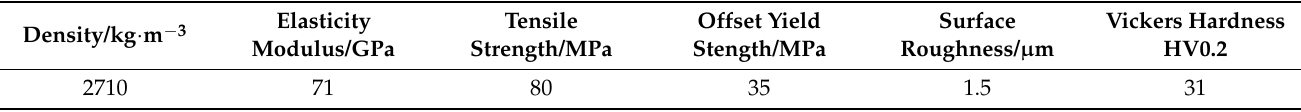
Table 2. Chemical composition of the sample (mass%) .